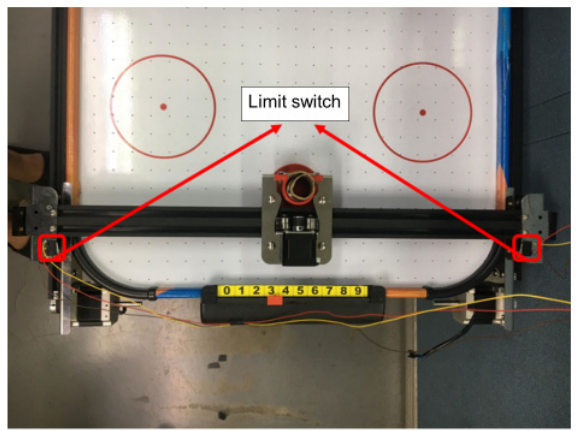
Figure 9. Limit switch installation diagram.